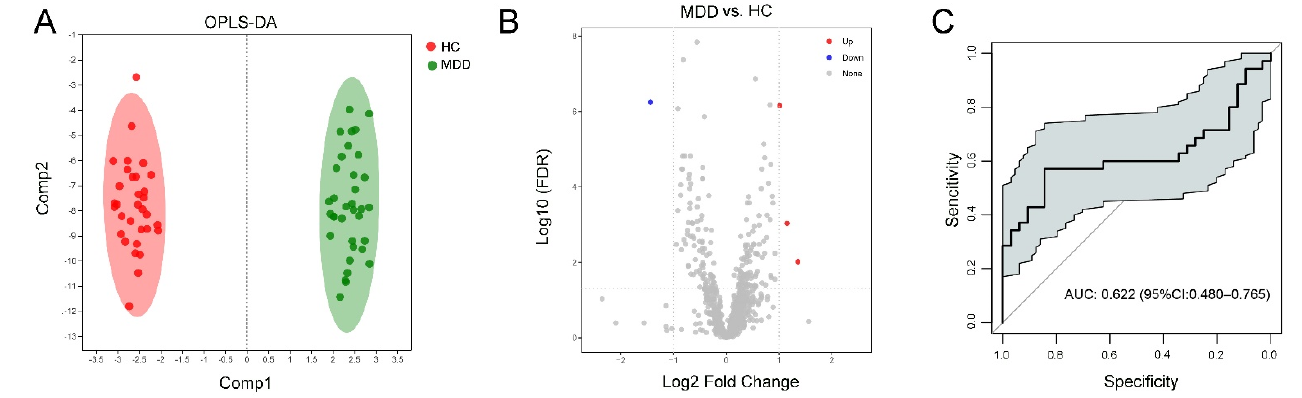
Figure 3. Differential lipid species between MDD and HC. ( A ) OPLS-DA model for MDD and HC, ( B ) volcano map showed the differential species (red dots indicated the increased lipid species and blue dots indicated the decreased lipid species) between MDD and HC participants, and ( C ) ROC analysis for the combinational lipids.